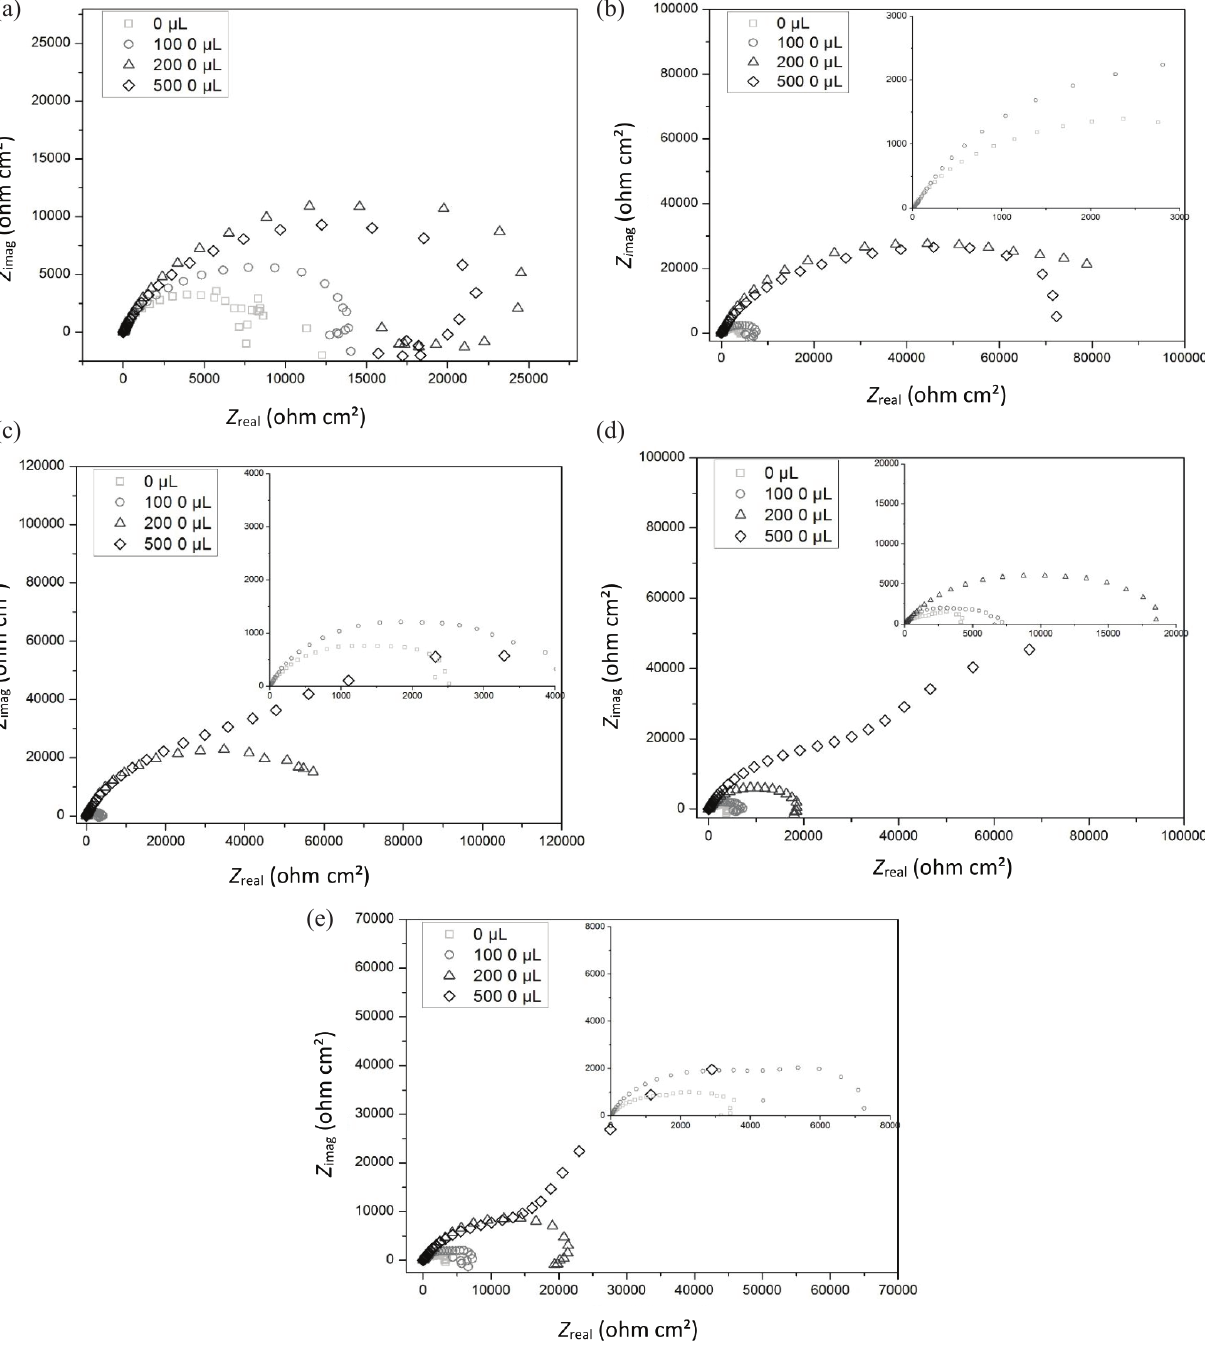
Fig. 1 – Nyquist diagram at different immersion times: (a) 1 hour, (b) 96 hours, (c) 360 hours, (d) 600 hours, and (e) 720 hours